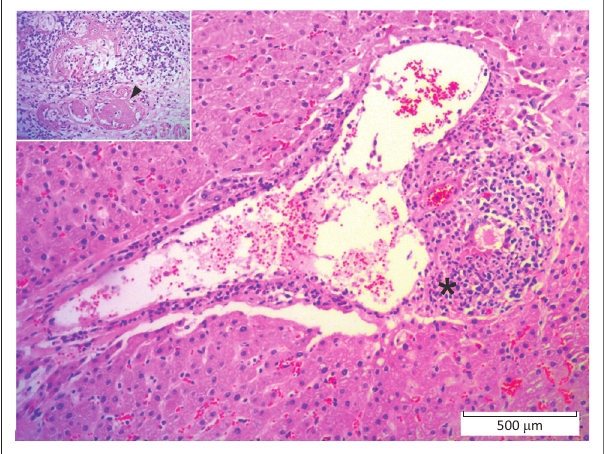
FIGURE 4: Liver, African buffalo. Portal triad with necrotising and lymphocytic vasculitis ( * ) because of Ovine herpes virus -2 infection (malignant catarrhal fever). Inset : vascular profiles are obscured by fibrinoid necrosis (arrowhead). Haematoxylin and eosin.